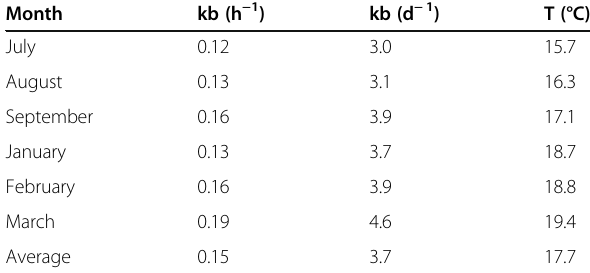
Table 1 Average monthly coefficient kb